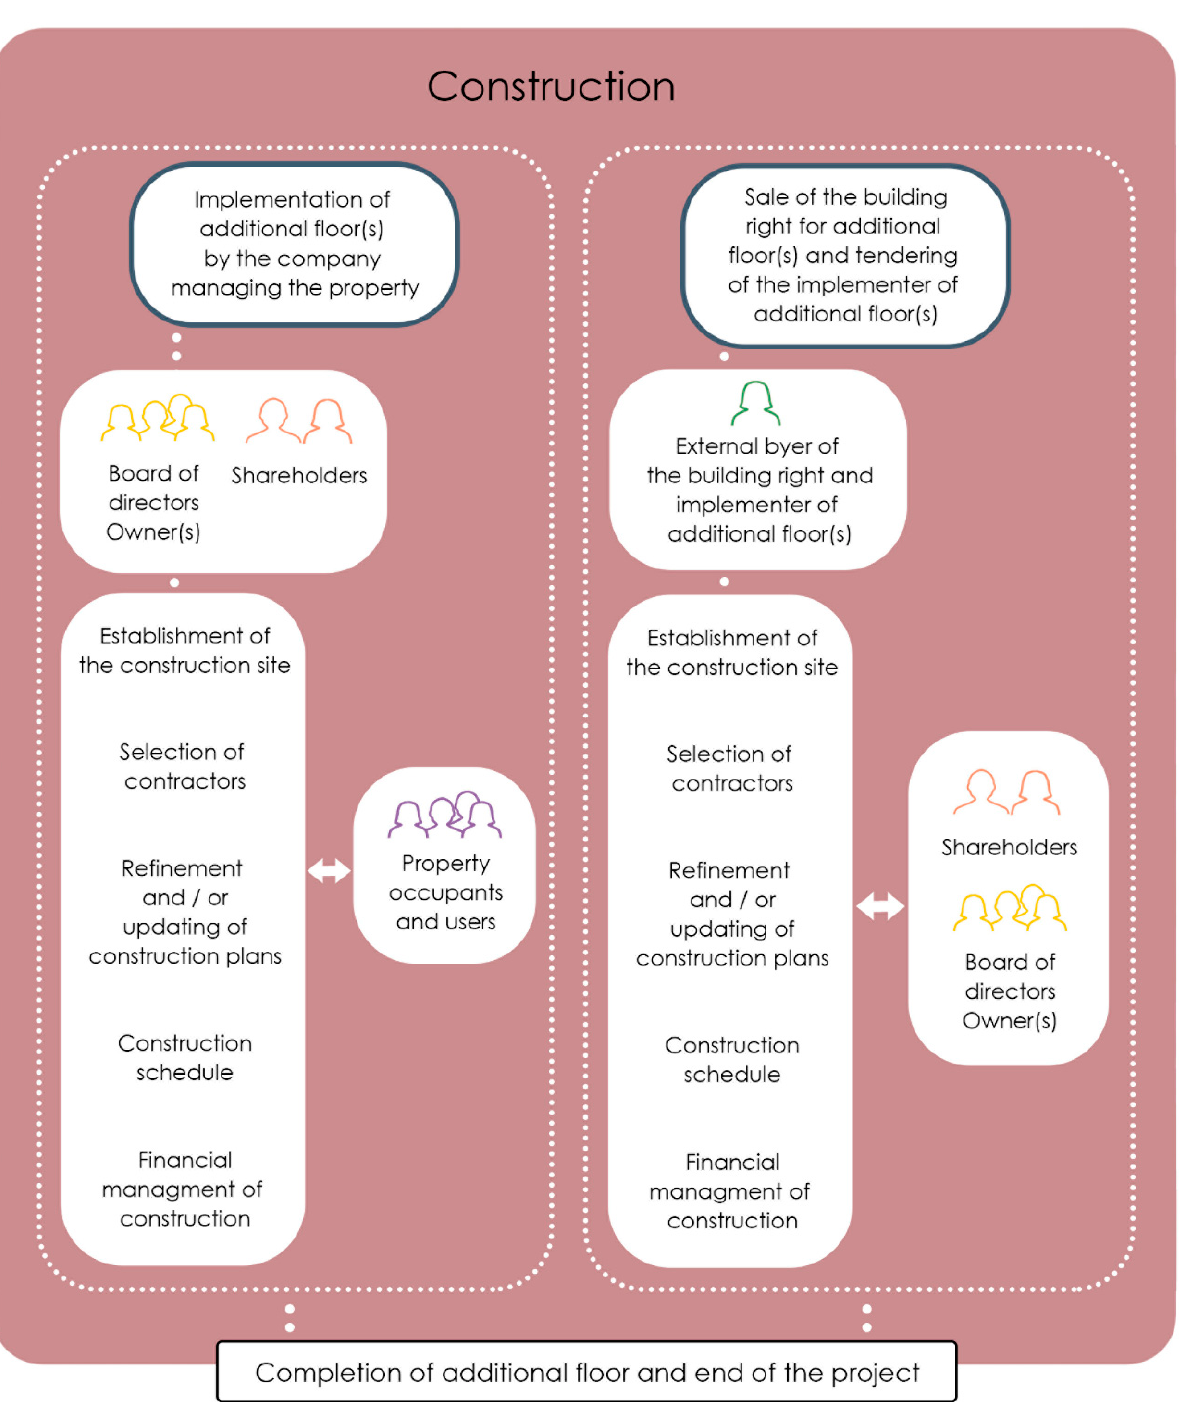
Figure 7. Construction of additional floors.